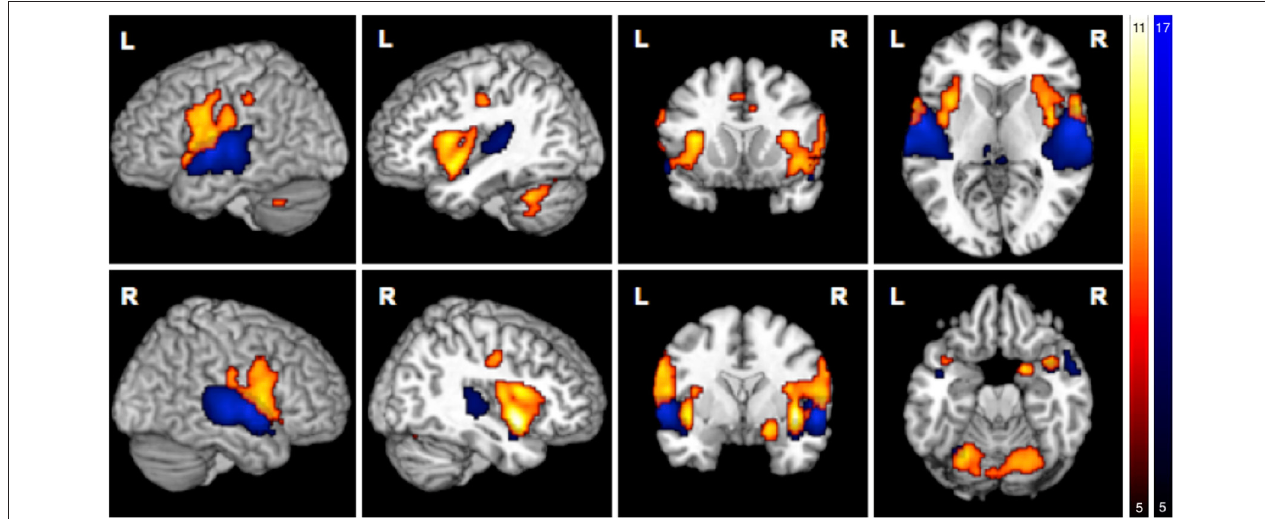
FIGURE 3 | Main effects in brain activity for olfaction and audition. BOLD responses for negative > neutral odor (O − > O 0 ) displayed in red. Blue clusters show BOLD responses for positive > neutral music (A + > A 0 ). FWE corrected at p < 0.05, k > 5.